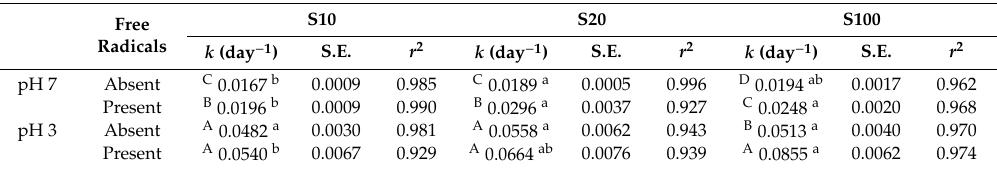
Table 3. E ff ect of pH and water-soluble free radicals on the degradation rate constant ( k ) of lycopene in emulsions containing lauryl